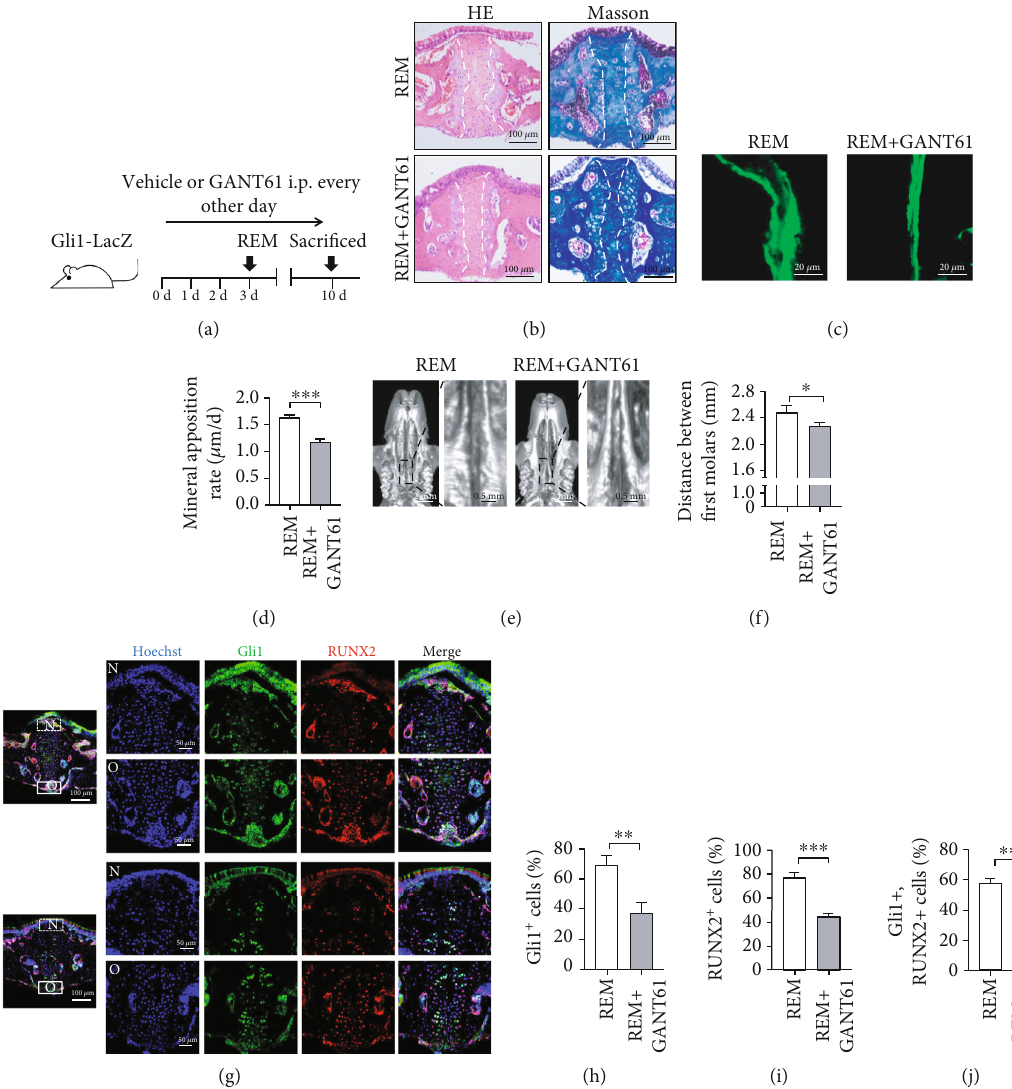
Figure 2: Pharmacological inhibition of Gli1 + cells suppresses mechanical force-induced maxillofacial bone remodeling. (a) Experimental procedure: Gli1-LacZ mice were treated with GANT61 every second day before they were sacri fi ced, and RME was induced on day 3 (RME+GANT61). Mice in the RME group were treated with vehicle. (b) HE and Masson ’ s staining showed decreased midpalatal suture remodeling in GANT61-treated mice. The midpalatal suture is shown between the two dotted lines. Scale bar: 100 μ m; n = 3 . (c) Calcein labelling shows that new bone formation is less in the RME+GANT61 group. Scale bar: 20 μ m; n = 3 . (d) New bone deposition rate decreased in the RME+GANT61 group, ∗∗∗ P < 0 : 005 ; n = 3 . (e) Micro-CT shows the horizontal plane views of maxillae of both groups. Scale bar: 2mm. The left panel shows magni fi ed sutures (in boxes), and GANT61-treated mice show narrow midpalatal sutures. Scale bar: 0.5mm. (f) The distance between two fi rst molars decreased in GANT61 application mice. ∗ P < 0 : 05 ; n = 3 . (g) Gli1 (green) and RUNX2 (red) expression in the midpalatal suture areas of both groups visualized by immuno fl uorescence staining. Scale bar: 100 μ m. Regions in boxes are magni fi ed in the right panel: “ N ” indicates the nasal side of the midpalatal suture and “ O ” indicates the oral side. Scale bar: 50 μ m. (h) Proportions of Gli1 + cells decreased in the nasal and oral sides and in the midpalatal suture in GANT61-treated mice. ∗∗ P < 0 : 01 ; n = 3 . (i) The proportions of RUNX2 + cells in the midpalatal suture decrease in the RME+GANT61 group. ∗∗∗ P < 0 : 005 ; n = 3 . (j) Gli1 + and RUNX2 + cells decreased in the sutures of the RME+GANT61 group. ∗∗ P < 0 : 01 ; n = 3